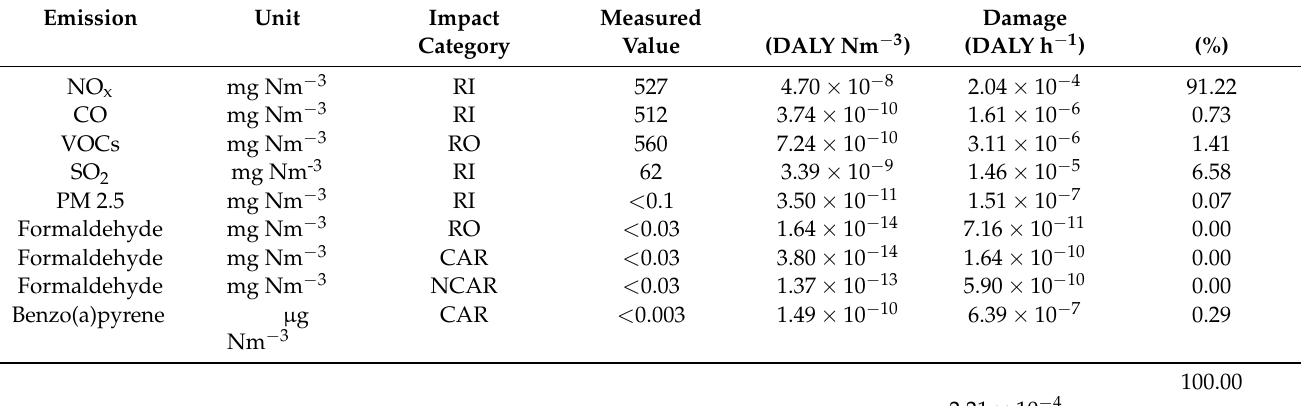
Table 1. Evaluation of the impact on human health of the most significant